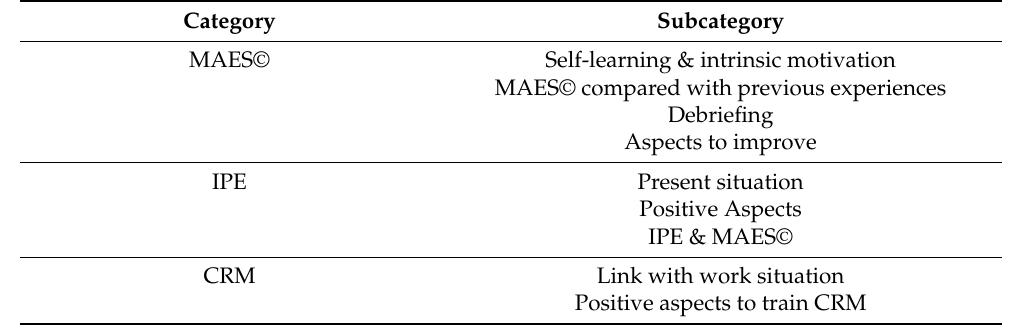
Table 3. Categories and subcategories of Focus